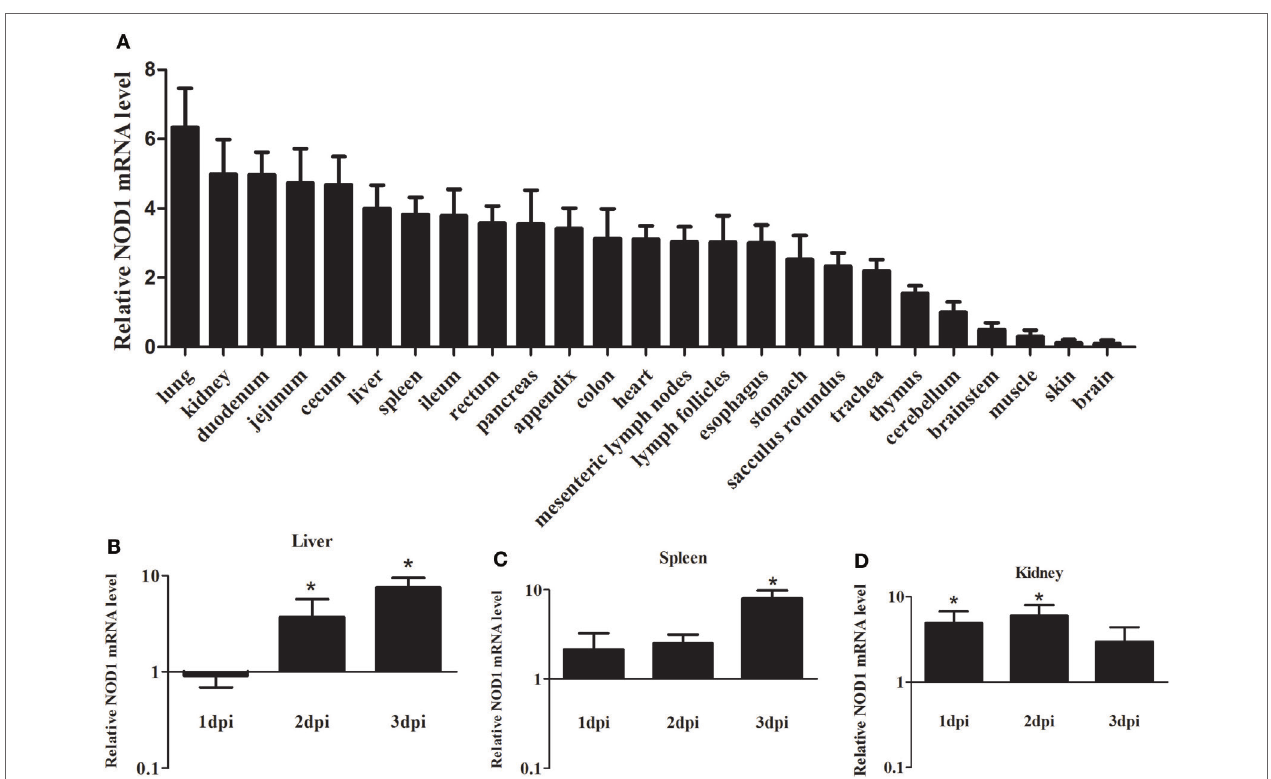
FigUre 2 | Expression profiles of rabbit nucleotide-binding oligomerization domain 1 (rNOD1) in rabbits. (a) Expression of rNOD1 in tissues of healthy rabbits. Expression of rNOD1 in the (B) liver, (c) spleen, and (D) kidney of rabbits infected with Escherichia coli (10 8 CFU). The relative expressions of rNOD1 were normalized to Gapdh . M ± SD from two independent repetitions are presented. Significant differences are indicated by